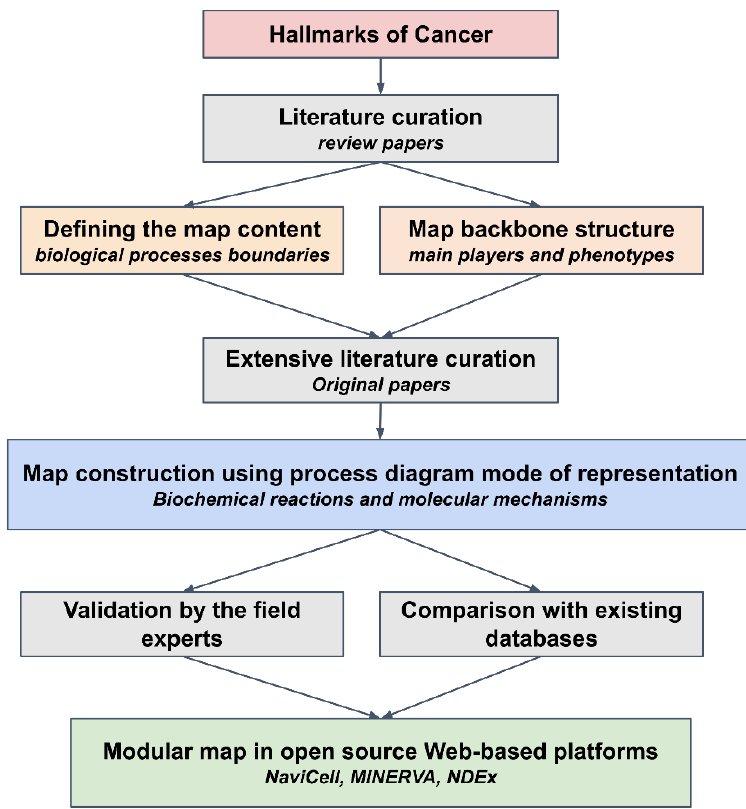
Figure 1. Regulated cell death map construction workflow. The scheme depicts the steps of map construction starting from a collection of cancer-specific and regulated cell death (RCD)-related information about individual molecular interactions from scientific publications and databases, manual annotation and curation of this information, then organization of the formalized knowledge in form of a global map with a modular structure.